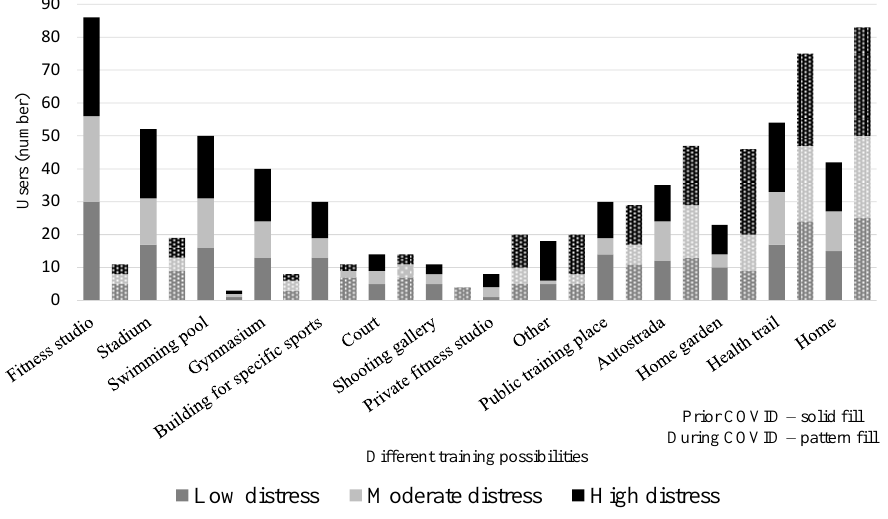
Figure 2. Training opportunities prior to and during the COVID-19 situation divided by results of EST-Q2.